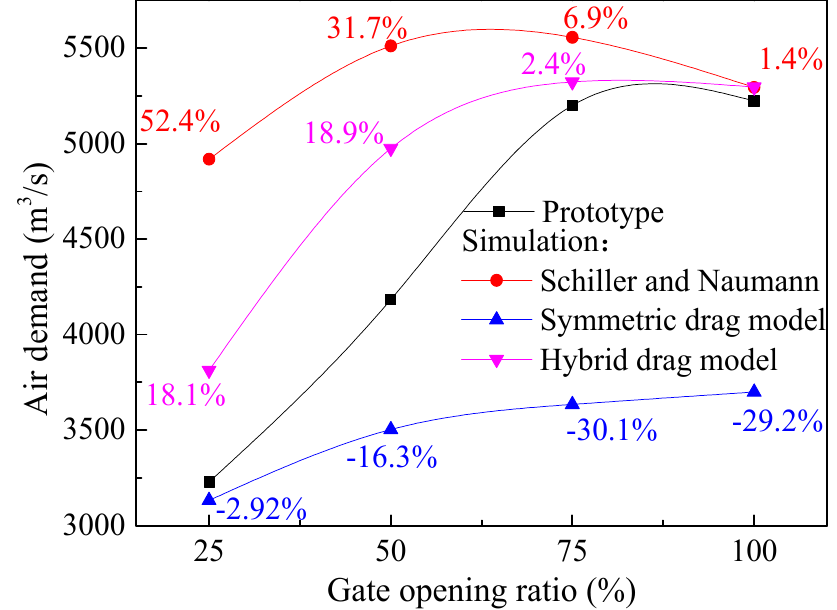
Figure 7. The comparison of air demand between prediction according to the different drag model and prototype data (the percentage on the lines represents relative prediction error).